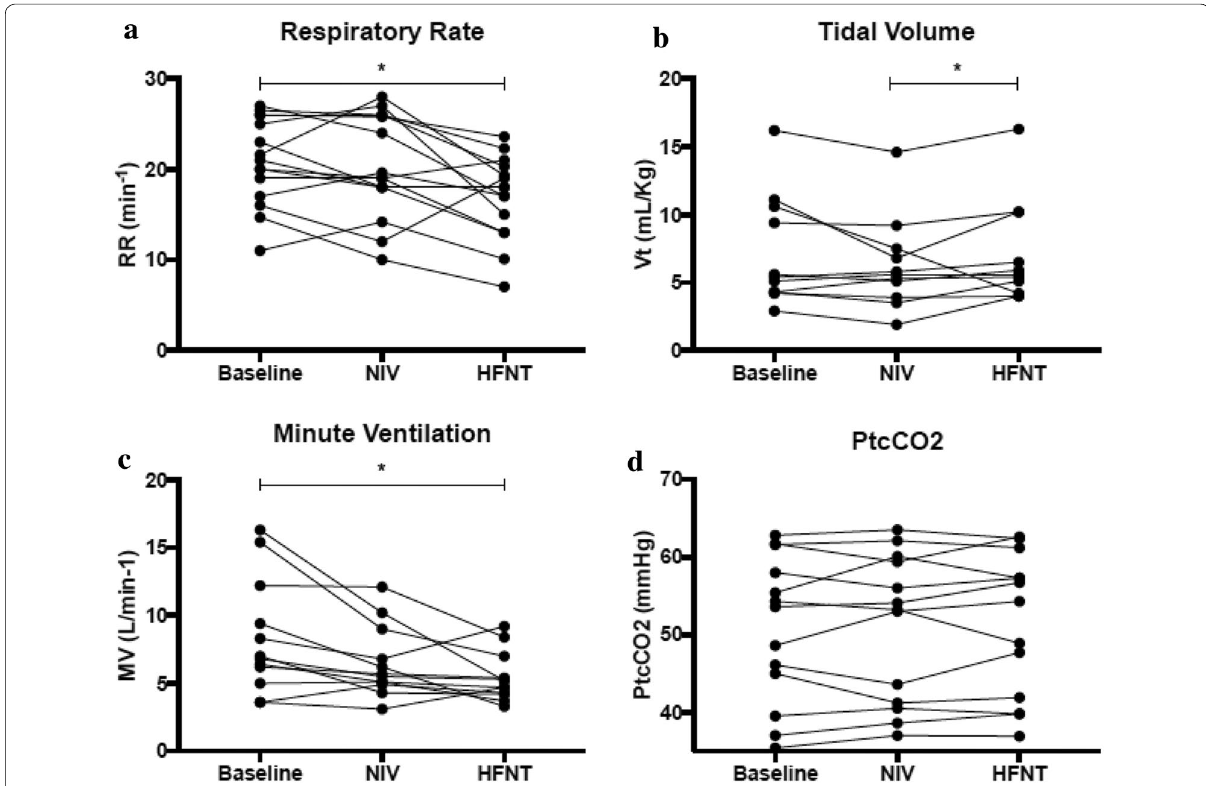
Fig. 3 Individual patient changes in respiratory variables. a HFNT significantly reduced respiratory rate compared to baseline and b significantly increased tidal volume when compared to NIV, c HFNT significantly reduced minute ventilation compared to baseline conditions, d no differences were observed for PtcCO 2 , * p < 0.05 (versus baseline). HFNT high-flow nasal therapy, NIV noninvasive ventilation, PtcCO 2 transcutaneous carbon dioxide,